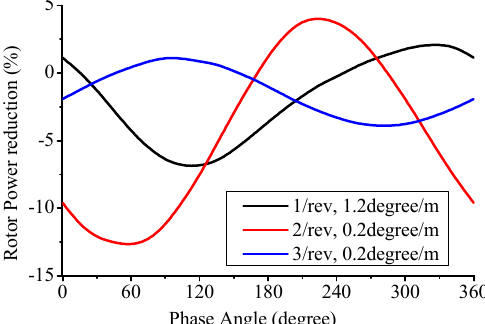
Figure 12. Rotor power reduction of uniform twist control with the 1~3/rev inputs for condition B.